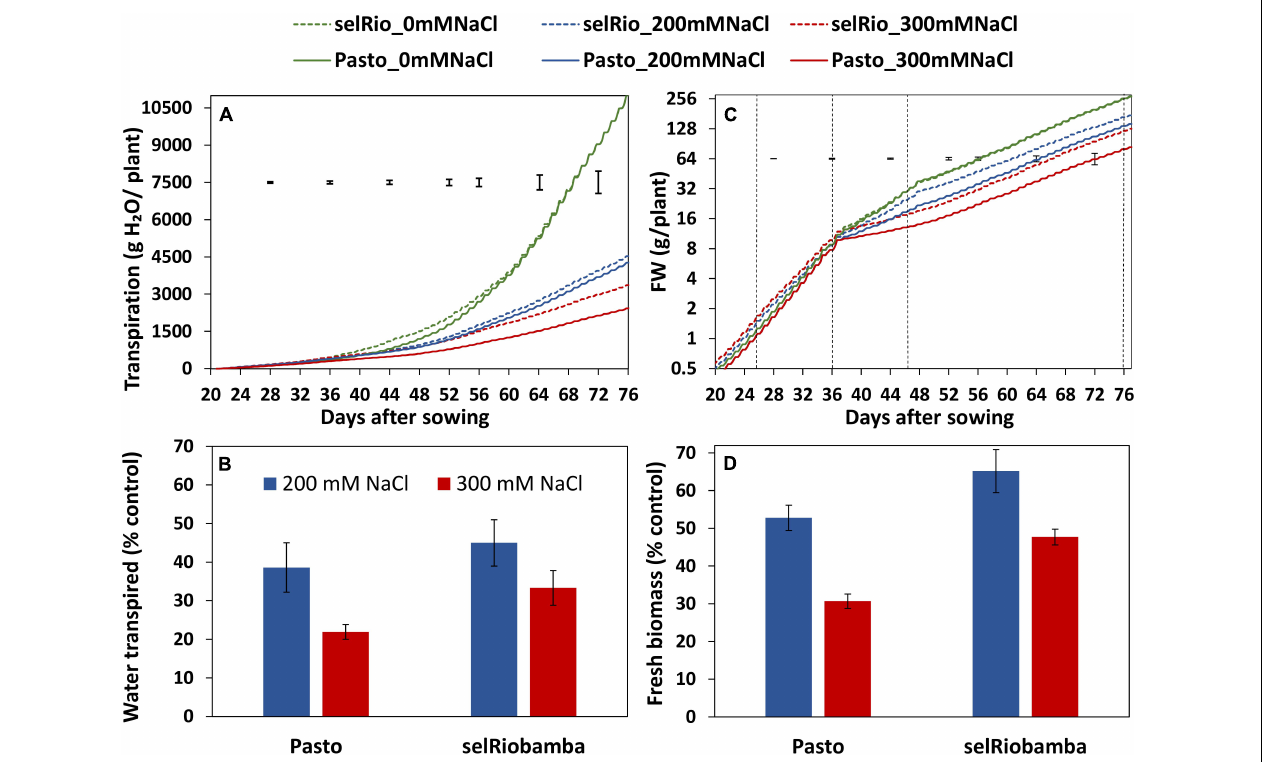
FIGURE 2 | Dynamics of transpiration and growth throughout the season. (A) Cumulative plant transpiration in two varieties (Pasto and selRiobamba) and three salt concentrations (control (0 mM NaCl), 200 mM NaCl and 300 mM NaCl). (B) Total water transpired by the plants at 77 DAS under salt stress as a percentage of the control. (C) Fresh biomass per plant. Fresh weights were interpolated based on RGRs estimated from destructive harvest from extra pots (days 11, 21, and 36 after sowing) or plants growing in the system (47 and 77 DAS). The dotted black lines in the graph indicate the dates of the harvest in which the interpolated weights were validated with the biomass data from the harvests (16, 26, 36, 47, and 77 DAS). (D) Fresh biomass of the plants at 77 DAS under salt stress as a percentage of the controls. Means of 4 plants. In panels (A,C) the error bars indicate the SEM (standard error of mean) from the ANOVA at a specific timepoint. In panels (B,D) the error bars indicate the SE of the individual